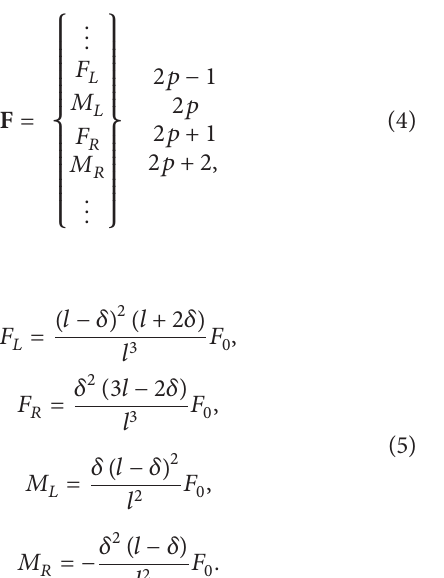
the distance along the element to the application point of 𝐹 0 .